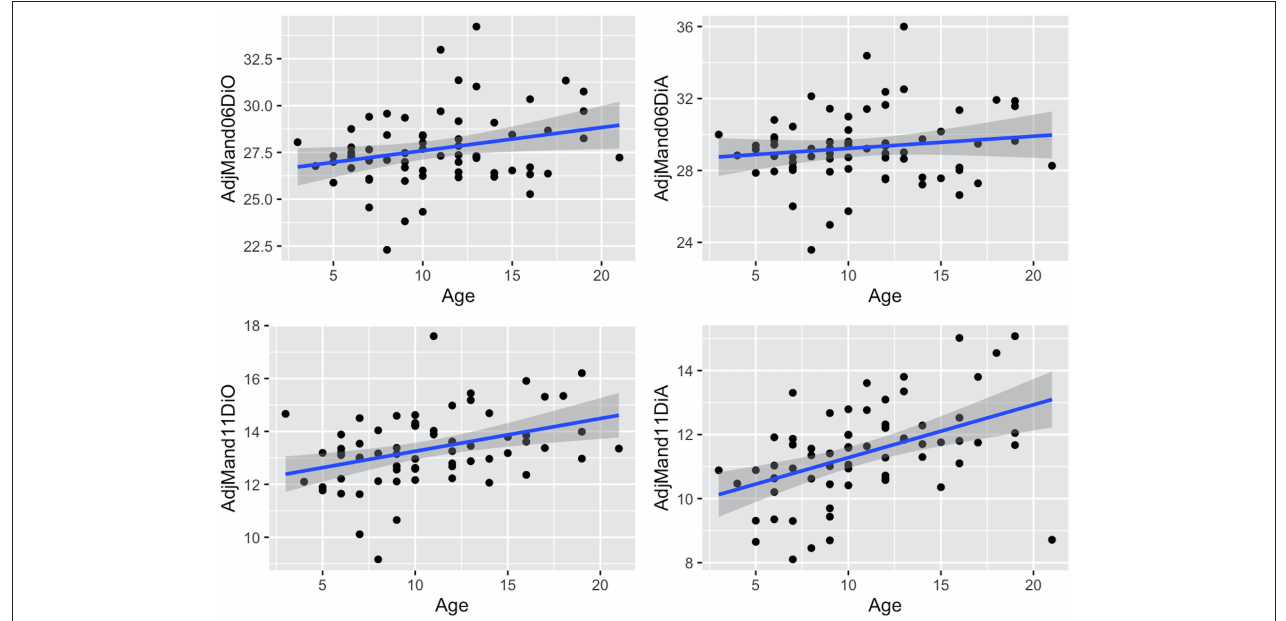
FIGURE 6 | Scatterplots with linear regression lines (blue) and confidence intervals (gray shading) plotted, showing associations between age (years) and adjusted rostro-caudal position measures (cm) (mean of left and right sides) for the maxillary cheek teeth in 67 horses. AdjMax06DiA, adjusted maxillary 06 disto-apical measurement; AdjMax06DiO, adjusted maxillary 06 disto-occlusal measurement; AdjMax11DiA, adjusted maxillary 11 disto-apical measurement; AdjMax11DiO, adjusted maxillary 11 disto-occlusal measurement. Negative measurements occur when the Triadan 11s are caudal to the orbit. and 68%, respectively, for maxillary 11s and mandibular